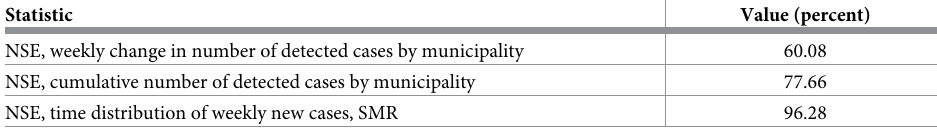
Table 3. Model fit as measured by the Nash-Sutcliffe Model Efficiency